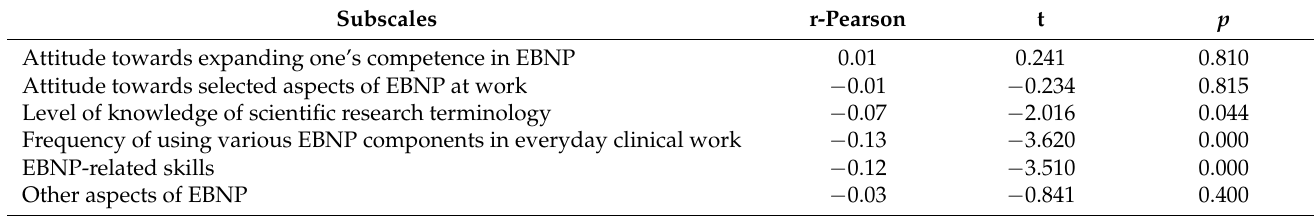
Table 3. Impact of the respondents’ age on the knowledge of, attitudes toward, and skills in EBNP according to the